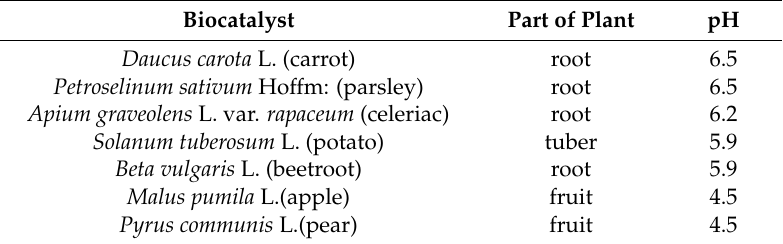
Table 1. The pH values of natural cell juice for the selected